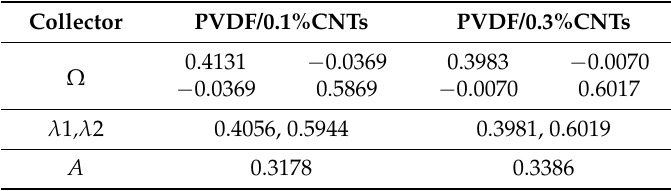
Figure 5. Orientation analysis for nanofibers collected on conventional collector ( a ) PVDF/0.1%CNTs nanofiber mat, and ( b ) PVDF/0.3% CNTs nanofiber mat. Table 2. Orientation matrices ( Ω ) , Eigen values ( λ 1 , λ 2) and anisotropy index ( α ) for the conventional collector.